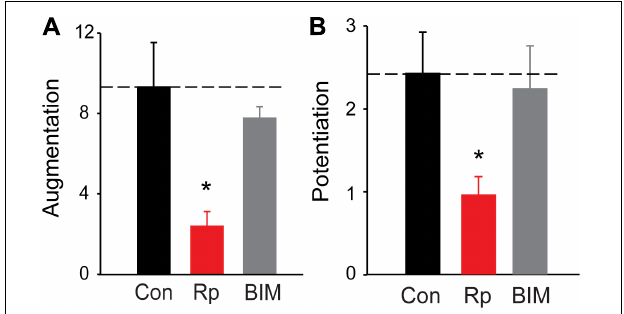
FIGURE 4 | Roles of PKA and PKC in augmentation and potentiation. (A) Amplitude of augmentation measured in TWT neurons in control conditions (black), as well as in the presence of the PKA inhibitor Rp-cAMP (red) and the PKC inhibitor BIM (gray). (B) Amplitude of potentiation the same conditions indicated in panel (A) . Values indicate means, determined as in Figure 2 , error bars indicate ± SEM, and asterisks indicate significant differences compared to values measured in control conditions (dashed